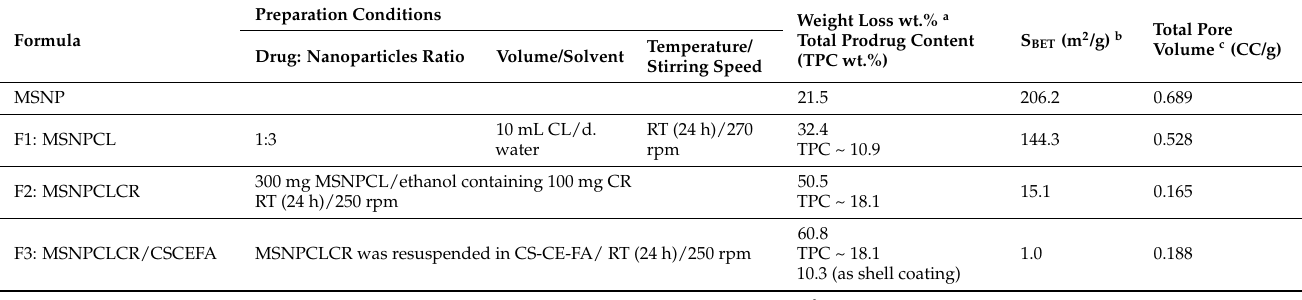
Figure 3. Thermal properties of MSNPs, nanoformulations, and free natural agents by STA–DSC analysis. ( A ) The mass loss analysis by STA at all stages. ( B ) DTG patterns at all stages according to mass loss. ( C ) The differential scanning calorimetry. (DSC) Thermograms at all stages. Table 1. Conditions for preparation of single and co-delivery nanoformulations using colchicine and curcumin natural agents and their physicochemical characteristics.